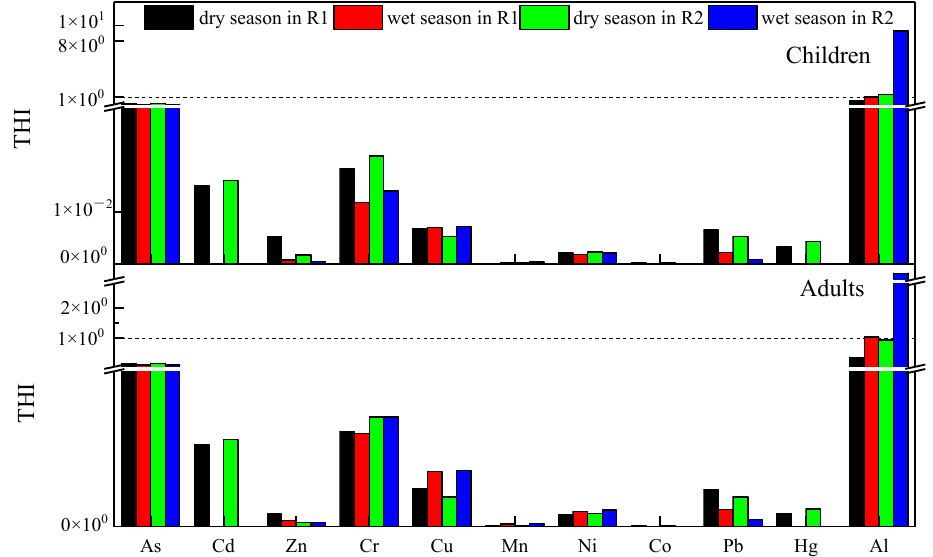
Figure 7. Total hazard index (THI) evaluation in the sampling sites for selective aged groups.